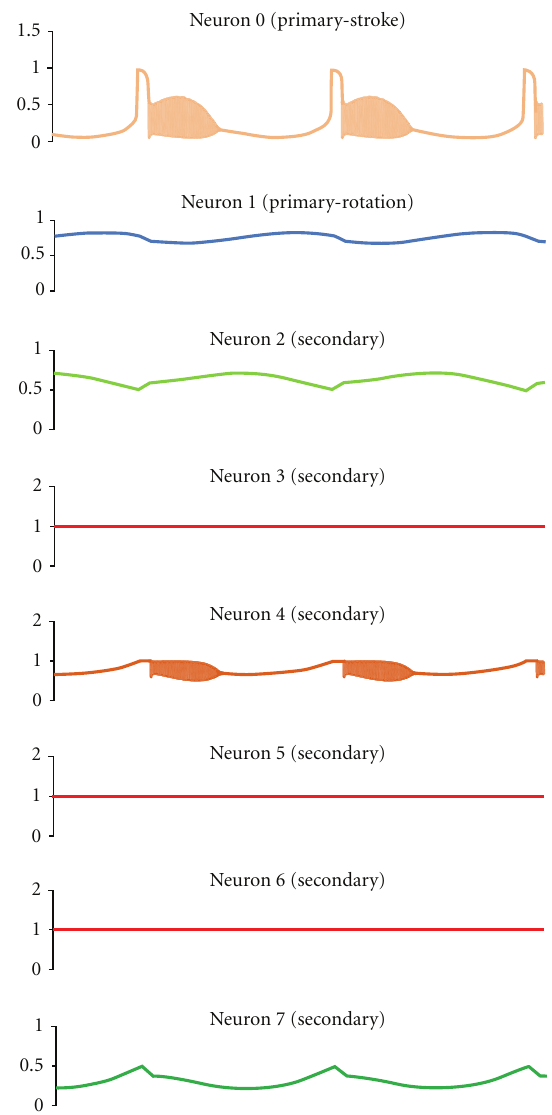
Figure 12: The above figure shows the neuron output state dynamics of each neuron in the fully connected original eight neuron controllers produced during the flight control of the MFWR to provide optimal cruise